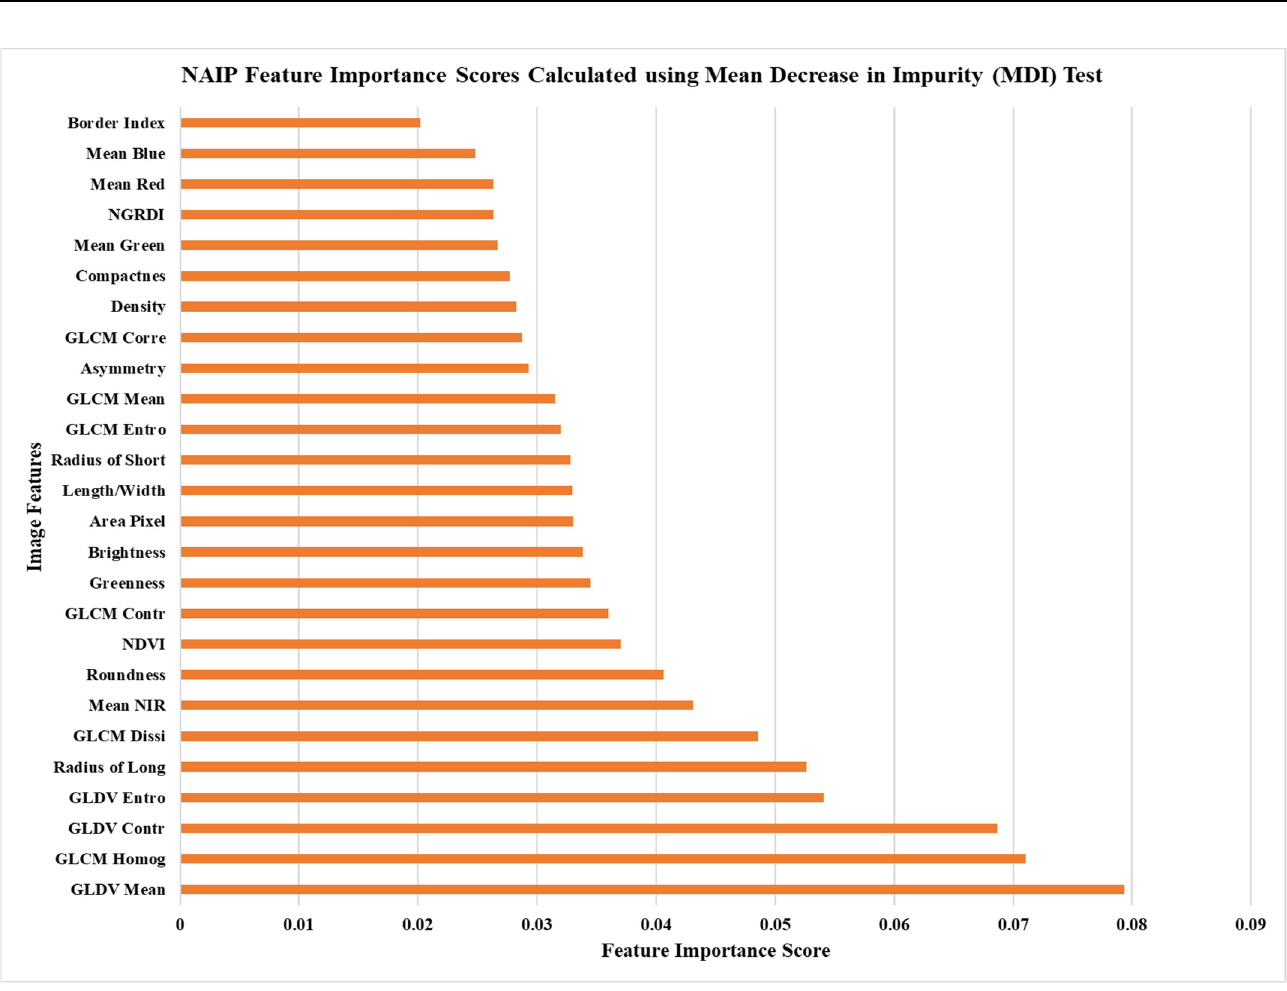
Figure 2. Mean decrease in impurity (MDI) image feature scores calculated using the NAIP imagery and random forest classifier. Table 3. Forest health thematic map accuracy assessment error matrix produced using the NAIP imagery, random forest (RF) supervised classification algorithm, and feature reduction digital classification method. The classes represented in this error matrix include: coniferous (C), deciduous (D), coniferous stressed (CS), deciduous stressed (DS), and snag (dead/degraded).